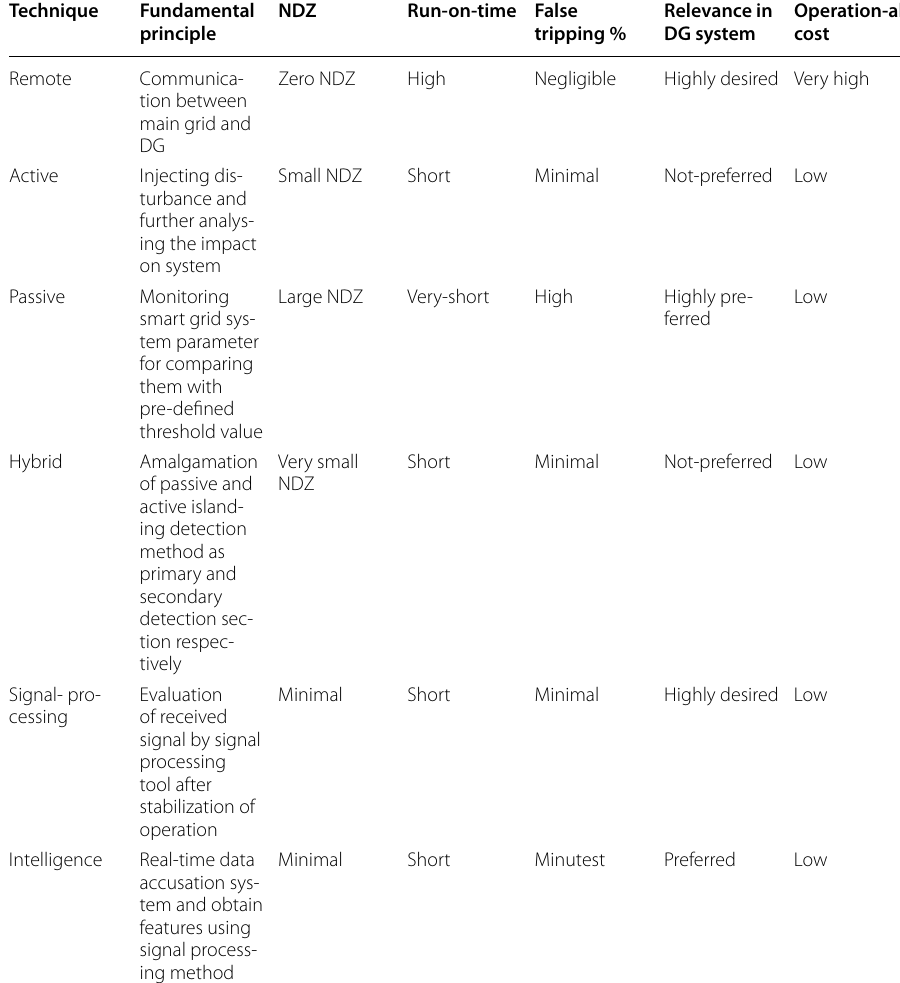
Table 7 Comparison between different island detection methods